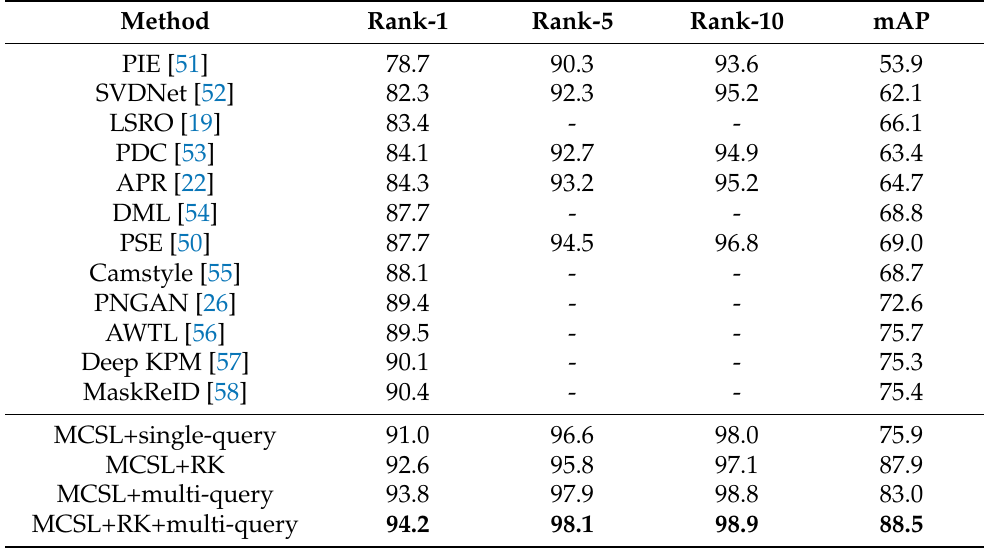
Table 3. Comparisons of rank-1, rank-5, rank-10, and mAP with different methods on the Market-1501 dataset. Bold fonts denote the highest values.